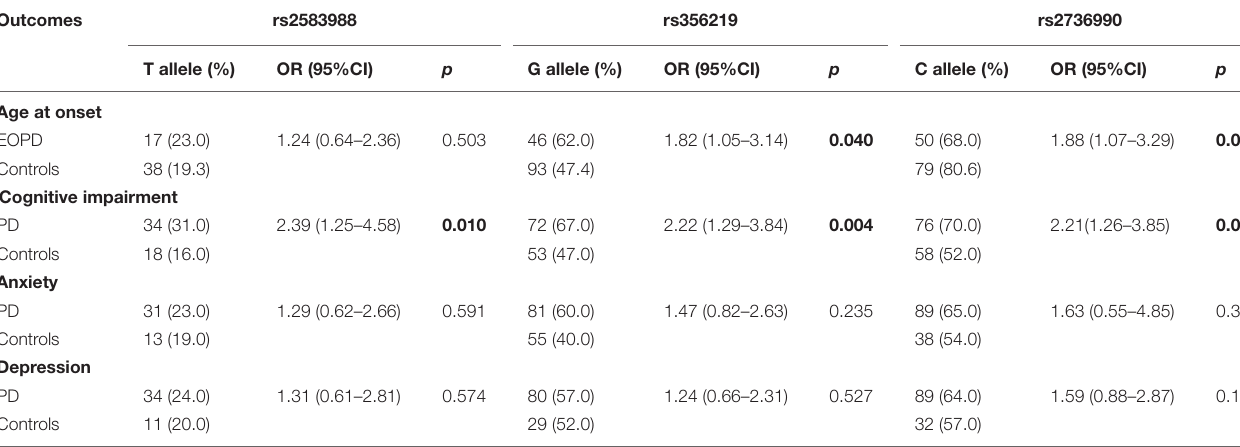
TABLE 4 | Comparisons of risk allele frequencies between case and control with non-motor clinical